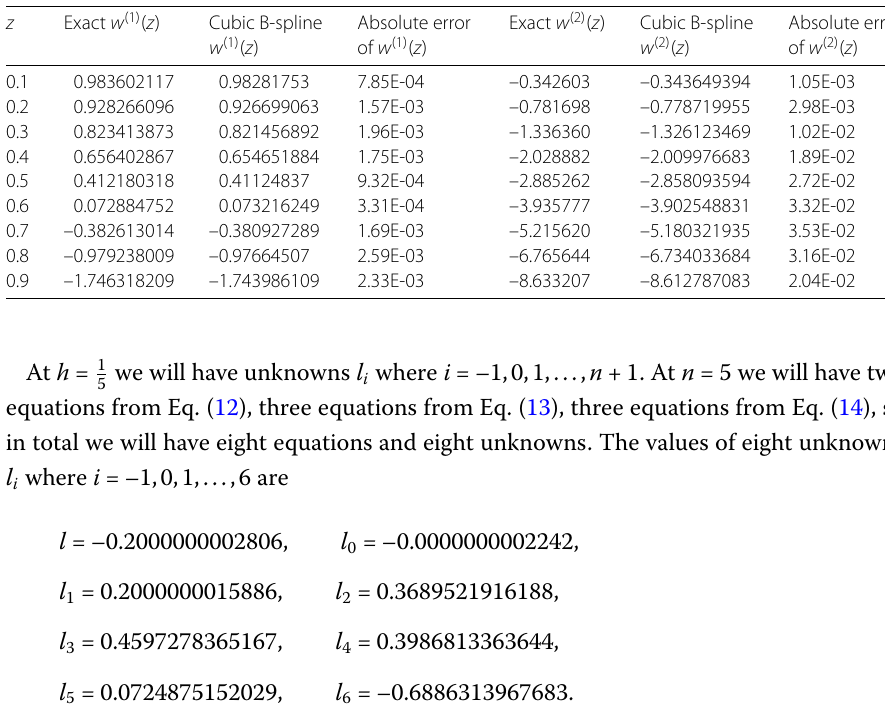
Table 9 Estimated derivative at the knots for Problem